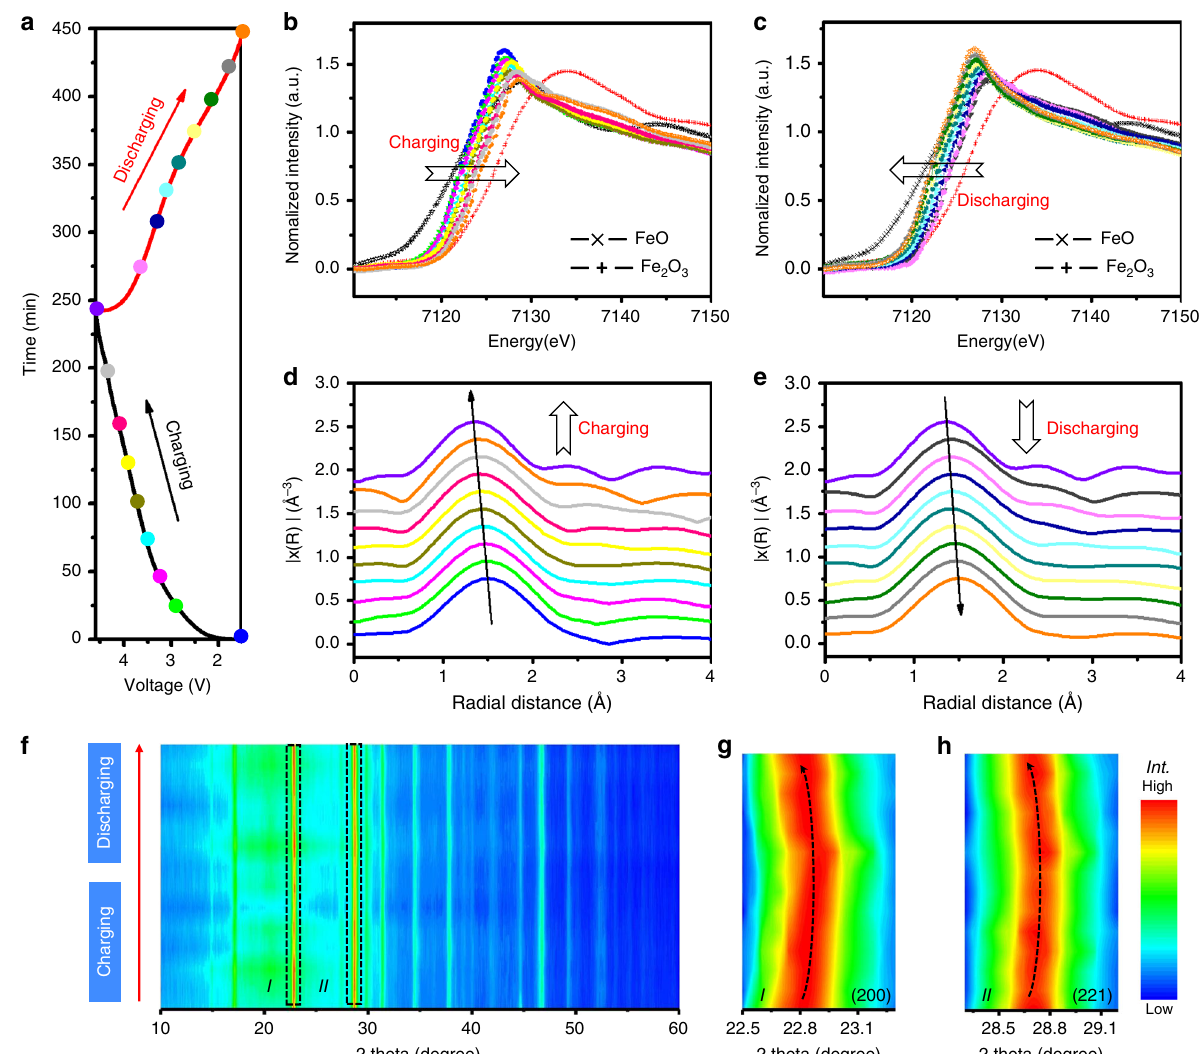
Fig. 3 The structural evolution and charge compensation mechanism of the KFeC 2 O 4 F cathode. a A typical galvanometric charging – discharging curve of a stabilized half cell in the window of 1.5 – 4.6 V at a current density of 0.1 A g − 1 and corresponding synchrotron Fe K -edge XANES during charging b and discharging c , and Fe EXAFS during charging d and discharging e . f Ex situ XRD of KFeC 2 O 4 F upon K ions extraction and reinsertion and the highlighted characteristic peaks in 22.5 – 23.3° corresponding to (200) plane g and 28.3 – 29.2° corresponding to (221) plane h